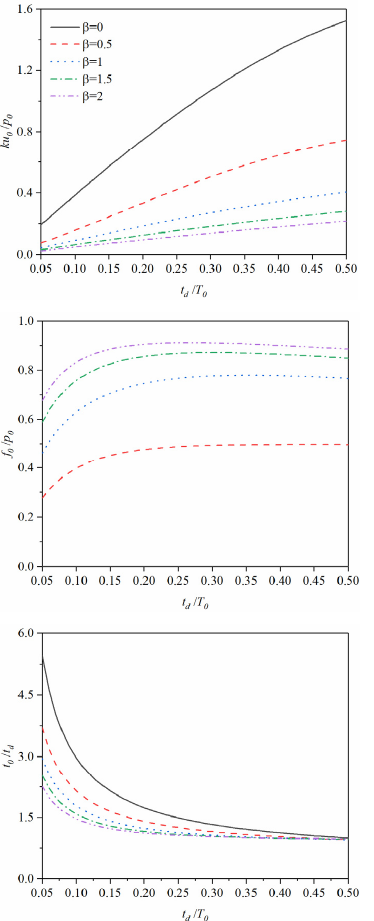
12 of 18 Figure 10. Time − histories of structural displacement under the three conditions. 4.5. Shock Response Spectrum The peak responses, such as structural displacement, damper force, elastic force, and time to reach maximum displacement, are usually of the most concern during the design. The SRS is a graph of the maximum response of the SDOF system as a function of its natural frequency in response to the loaded impulsive excitation [40]. It has been widely used for the prediction of structural responses or the design of related structural parame- ters to reach the target response. Figure 11 shows the SRSs of the SDOF system under half-cycle sine shock, and rep- resents the changes in peak responses with the ratio of duration to the natural period of the system for various mechanical parameters of the ECD. The SRSs of the structure sub- jected to other forms of shock impulse can be obtained by the same method, and therefore, not all of them are listed here. The maximum elastic force can be calculated by the known maximum displacement and the stiffness of the system k . Based on the SRS, the peak re- sponses of a certain system with certain design parameters of the ECD can be predicted, or the parameters of the system and the ECD can be designed for target peak responses. Because of the dimensionless characteristic, the SRS is applicable to a wide range of sys- tems. It can be noted that the dimensionless maximum displacement increases with the